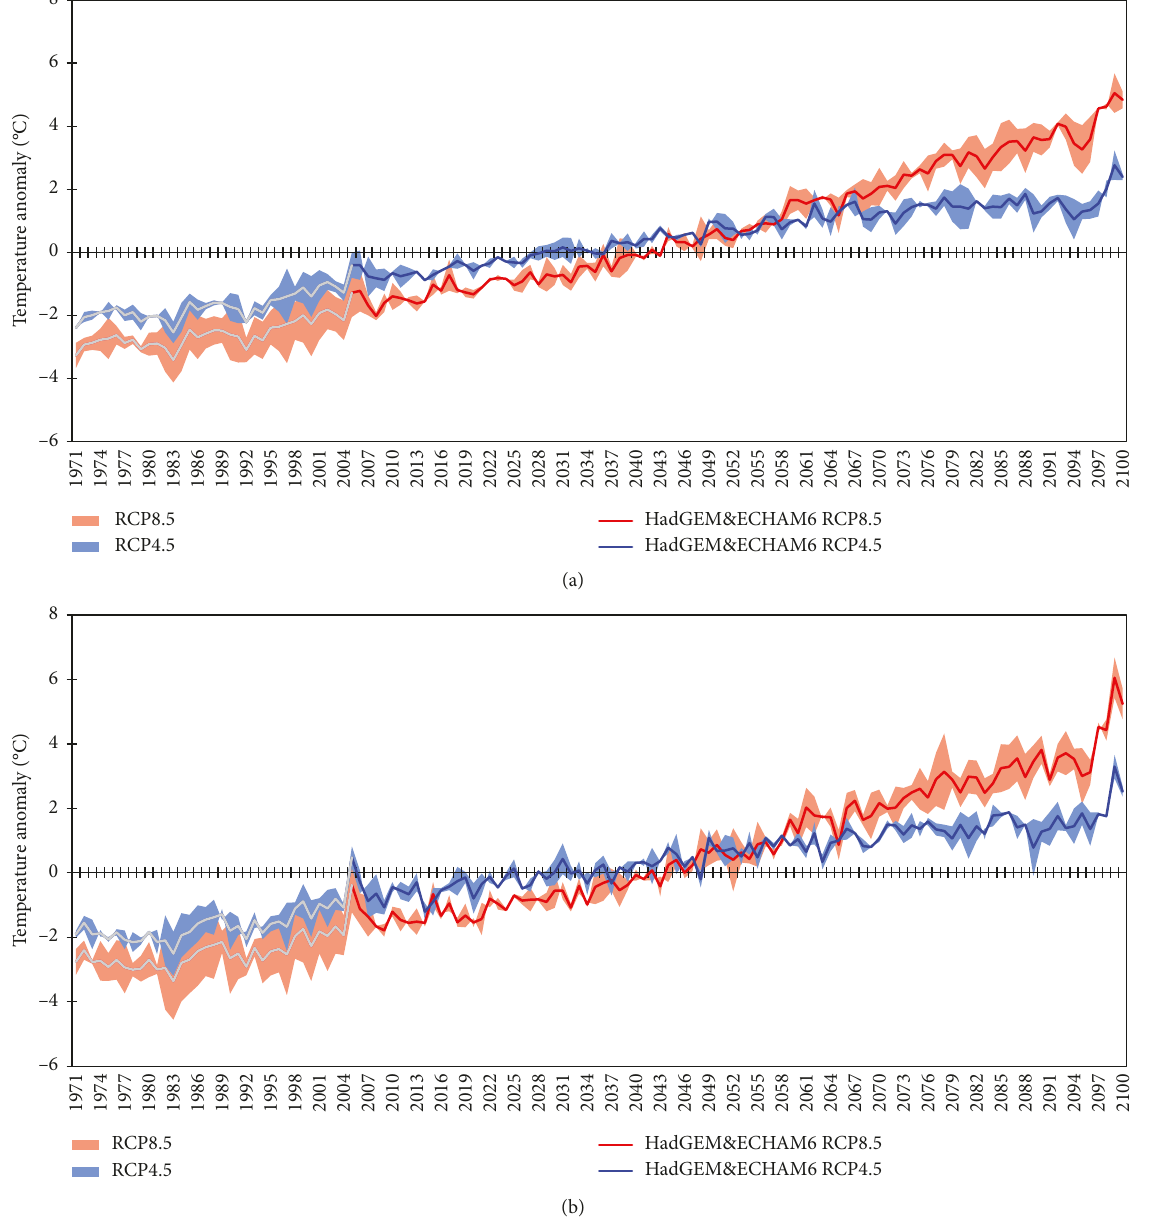
Figure 6: Changes in corrected temperature (base period temperature bias is added with each yearly value) for (a) CORDEX-MENA/Arab and (b) Arabian Peninsula subdomain for the period 1971–2100. Anomaly is obtained from any yearly value minus the average amount. Average is obtained from HadGEM2- and ECHAM6-driven runs for both RCP4.5 and RCP8.5. Shaded area shows the range and gray color indicates the past